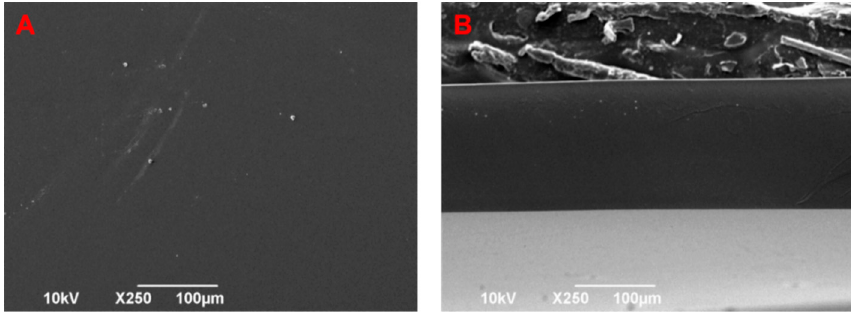
Figure A1. SEM images of the top-view ( A ) and cross-section ( B ) of a ciprofloxacin-loaded PVP foils.